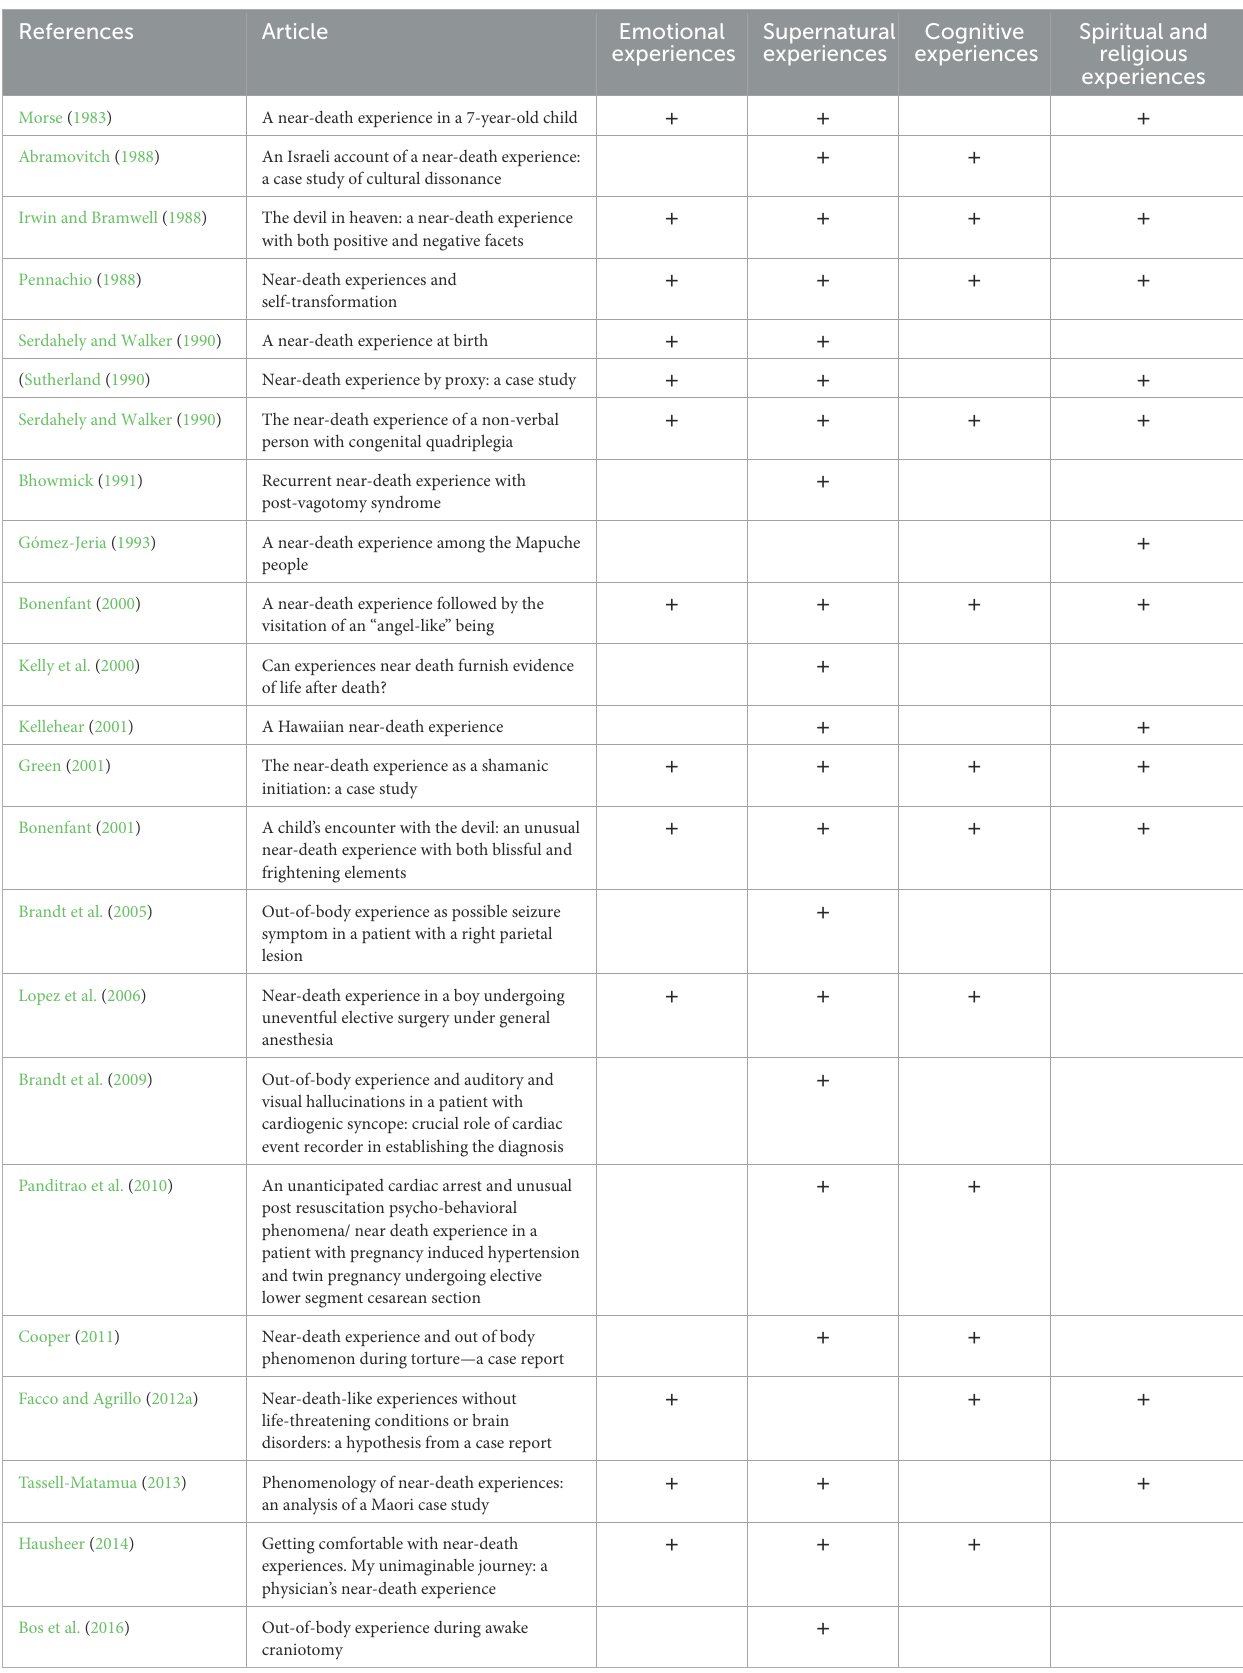
TABLE 4 The presence or absence of any category of experience in the included